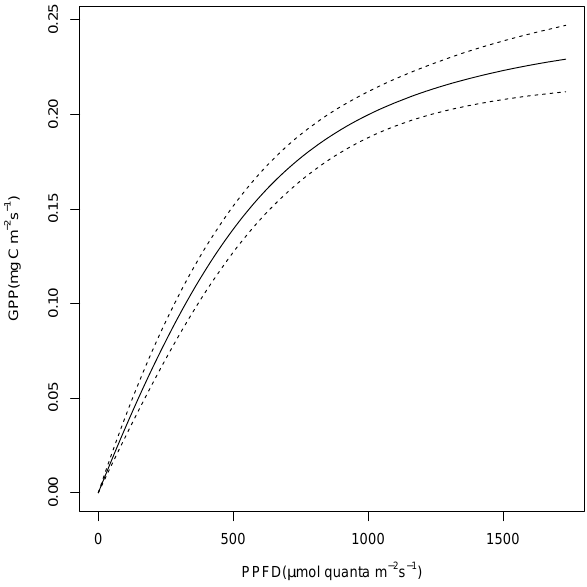
Figure 5. Median (solid line) and 95% credible intervals (dashed lines) of half-hourly gross primary production (GPP) with photo- synthetic photon flux density (PPFD) for a 10-day block (1 May to 10 May 2009, Julian days 121 to 130) for the choice of informative prior